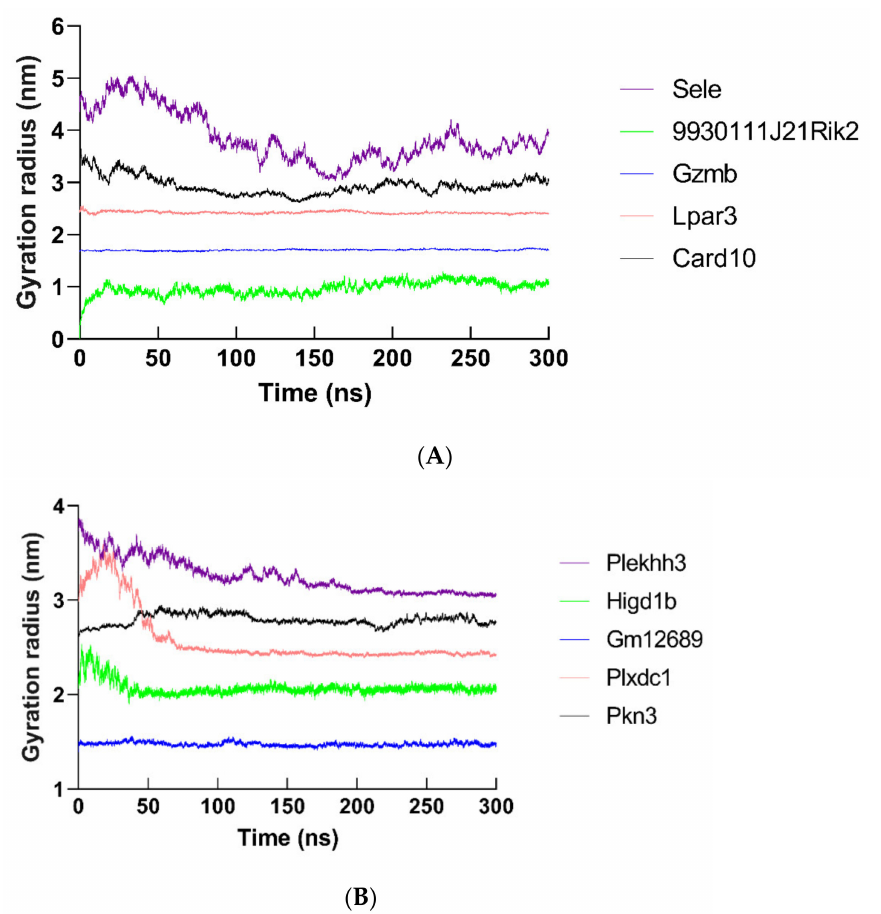
Figure 14. Gyration radius results of hub proteins in molecular dynamics simulation (300 ns). The gyration radius of ( A ) SELE, 9930111J21RIK2, GZMB, LPAR3, CARD10, ( B ) PLEKHH3, HIGD1B, GM12689, PLXDC1, and PKN3 was